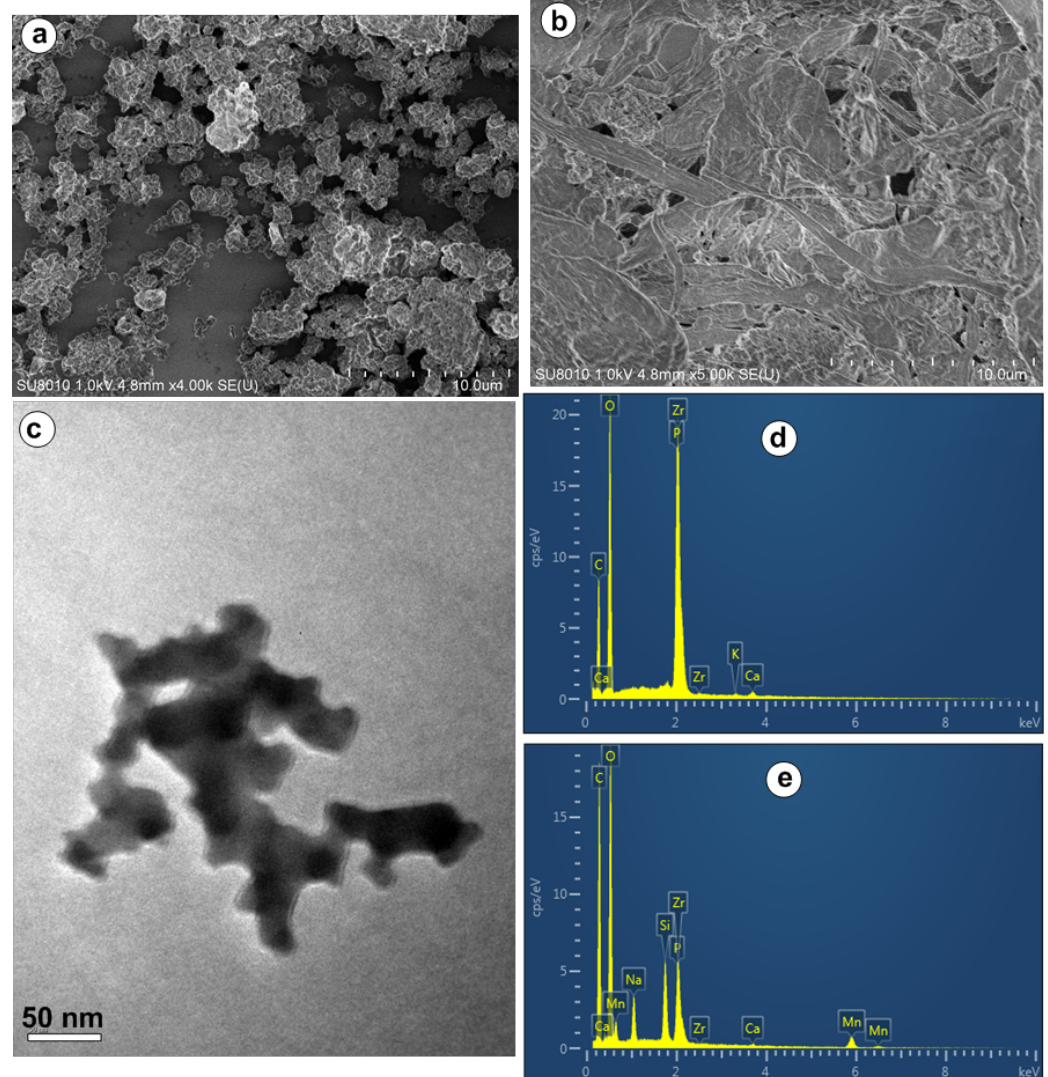
Figure 4. SEM photograph of ( a ) ZPS-PVPA, ( b ) catalyst 3, TEM photograph of ( c ) catalyst 3, and the measured EDS image of ( d ) ZPS-PVPA, ( e ) catalyst